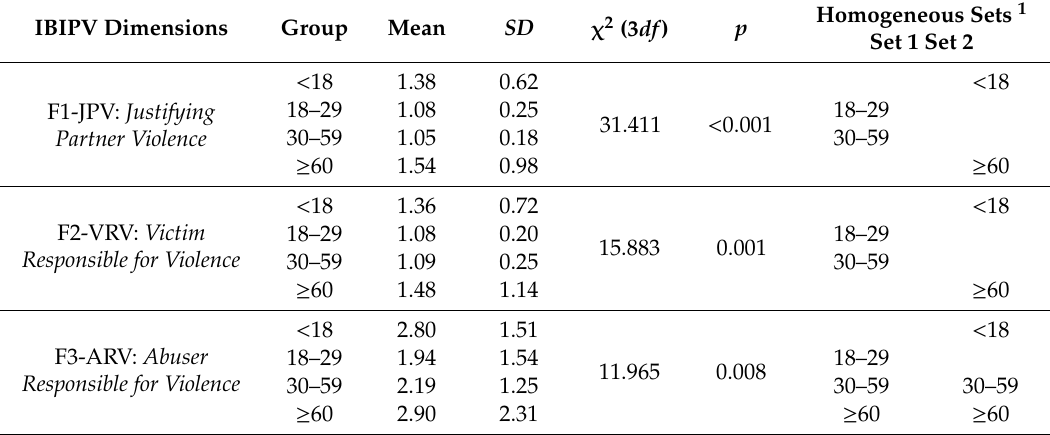
Table 3. IBIPV: Mean differences among age groups.